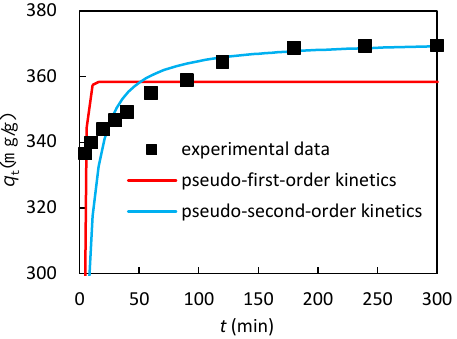
Figure 7. Adsorption kinetics of Pb 2+ on the as-prepared GO, C 0 = 150 mg/L, pH = 5.0, m/v = 0.3, and T = 298 K.